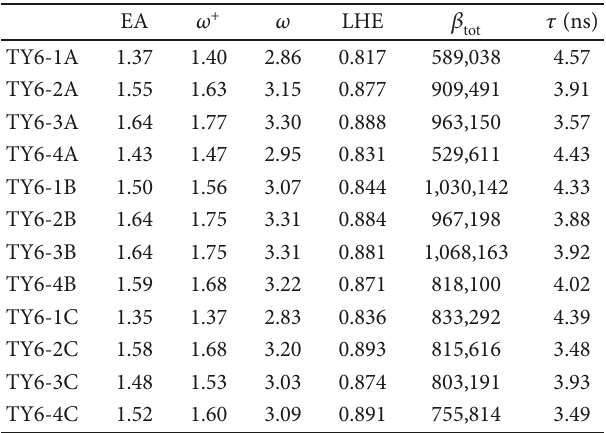
Table 13: Chemical reactivity parameters (eV), light harvesting e ffi ciencies (LHE), hyperpolarizabilities ( β ), and lifetime ( t ). tot EA ω + ω LHE β